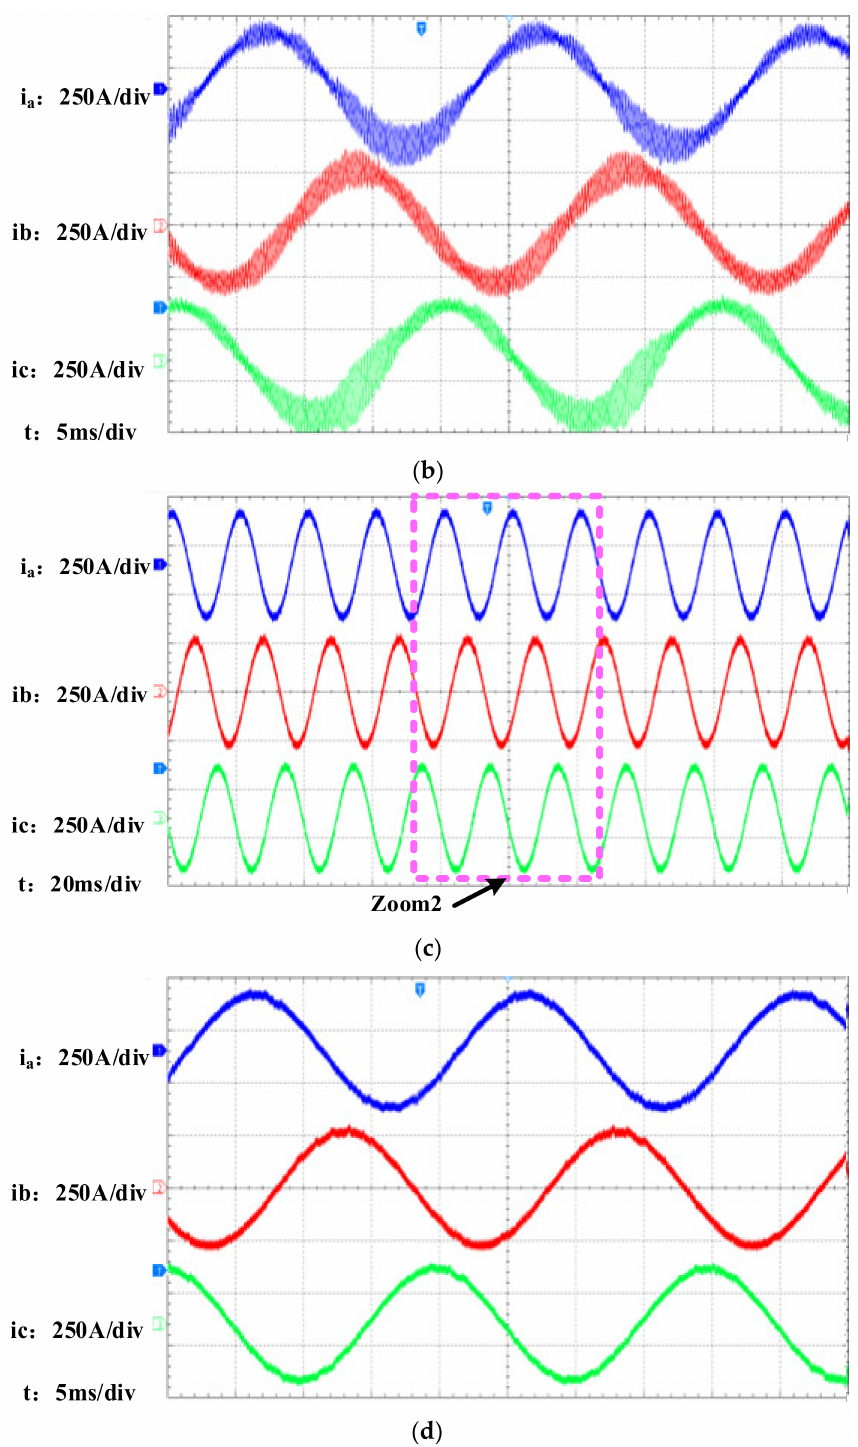
Figure 15. Grid current waveform during grid-connected resonance of the photovoltaic cluster inverter. ( a ) Without the proposed DOB; ( b ) the waveforms of Zoom 1; ( c ) with the proposed DOB; ( d ) the waveforms of Zoom